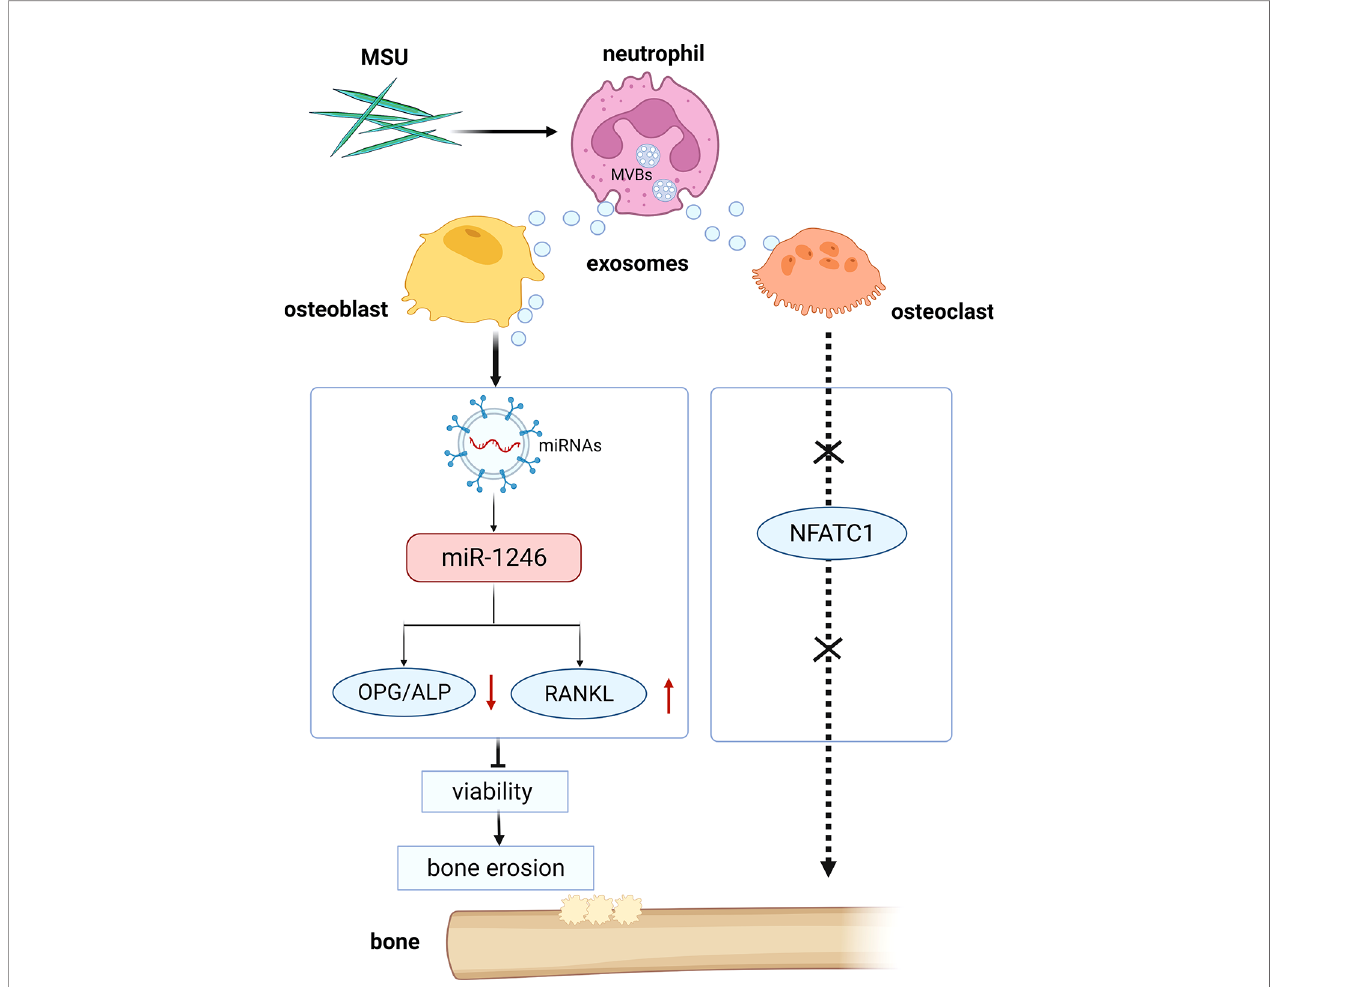
FIGURE 10 | Schematic diagram of the study. Neutrophil-derived miRNA-1246-overexpression exosomes induced by MSU inhibit the viability of